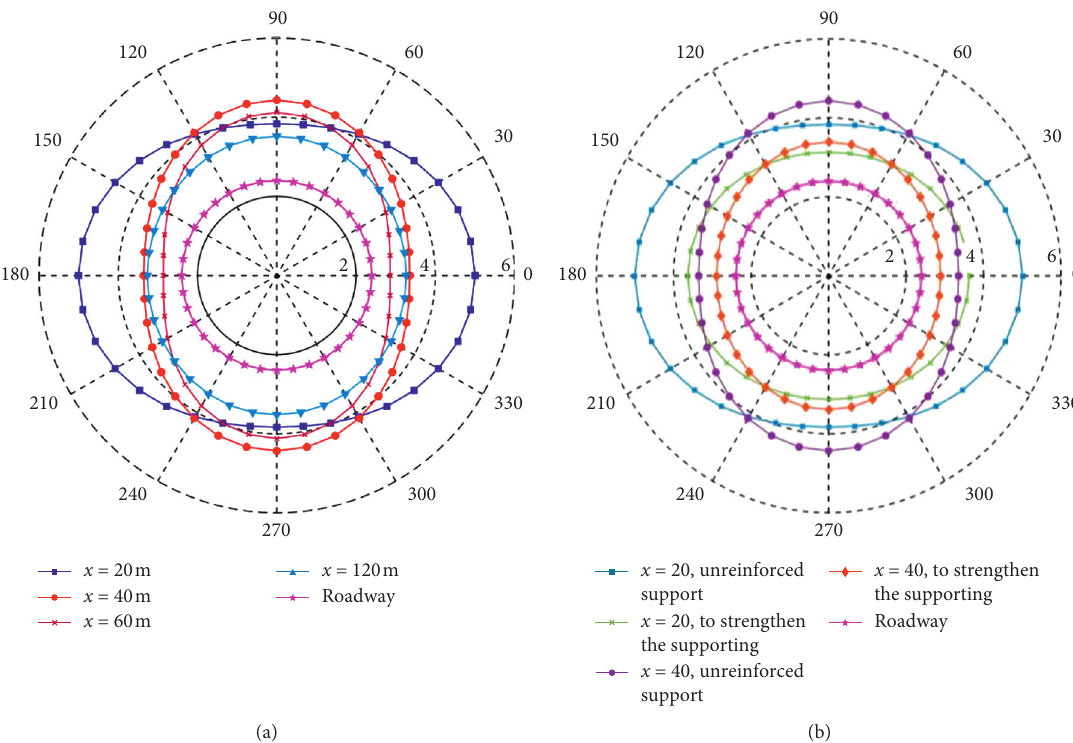
Figure 7: Failure radius diagram of the plastic zone of the surrounding rock of the roadway: (a) plastic zone radius of the surrounding rock with different advancing distances and (b) plastic zone radius of the surrounding rock before and after grouting reinforcement.